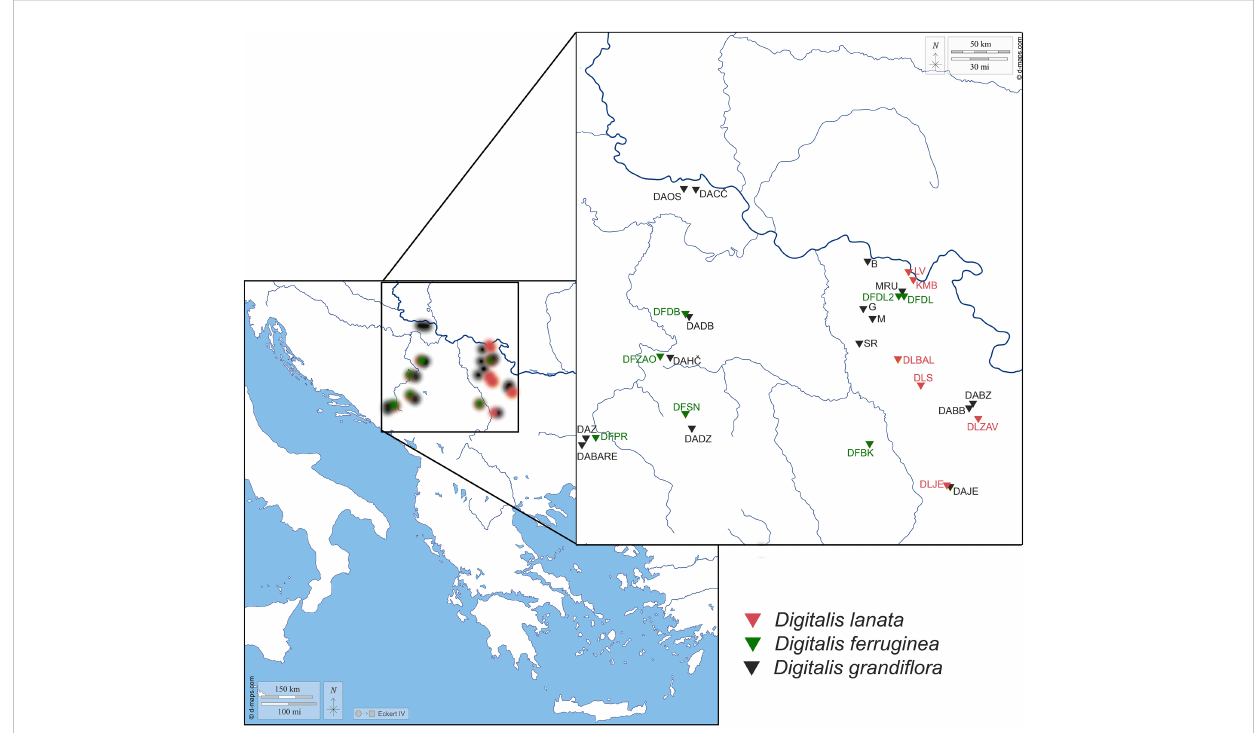
FIGURE 1 Map presenting the populations of Digitalis grandi fl oraa , D. lanata , and D. ferruginea originating from the central Balkan Peninsula analyzed within the present study. For the population labels, please refer to Table